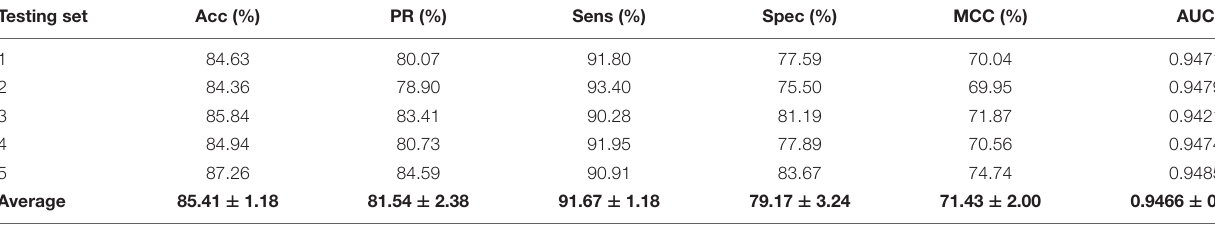
TABLE 2 | Five-fold CV results performed on the Zea mays dataset by the proposed model. Testing set